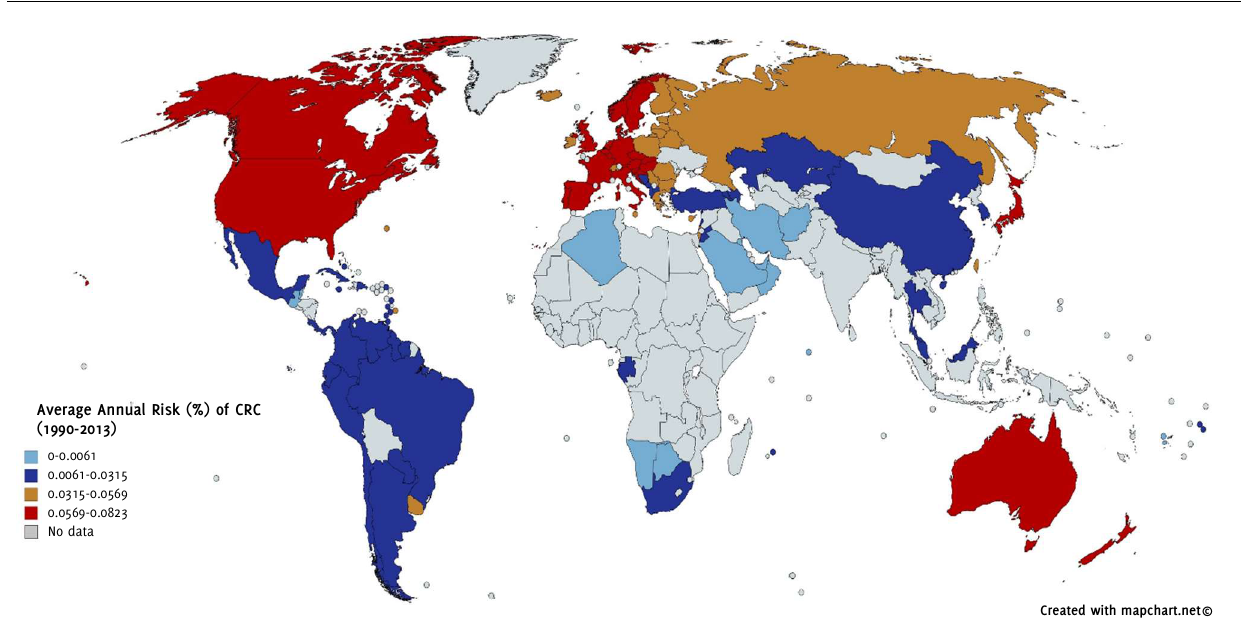
Figure 3 . Average Annual Risk (%) of Colorectal Cancer (CRC) of the Selected Countries,